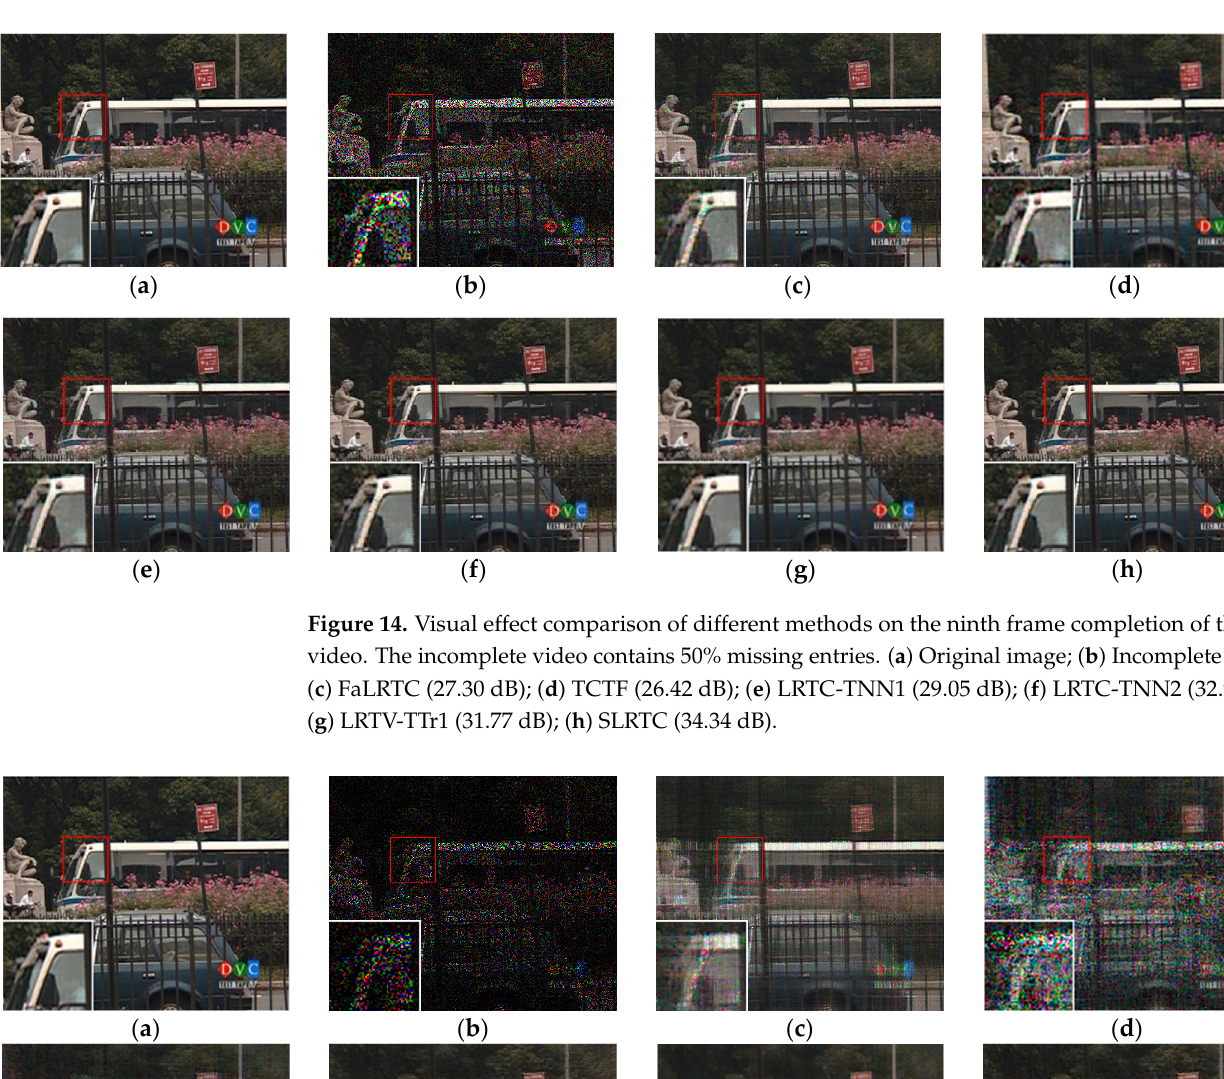
image; (c) FaLRTC (16.46 dB); (d) TCTF (11.53 dB); ( e ) LRTC-TNN1 (18.69 dB); (f) LRTC-TNN2